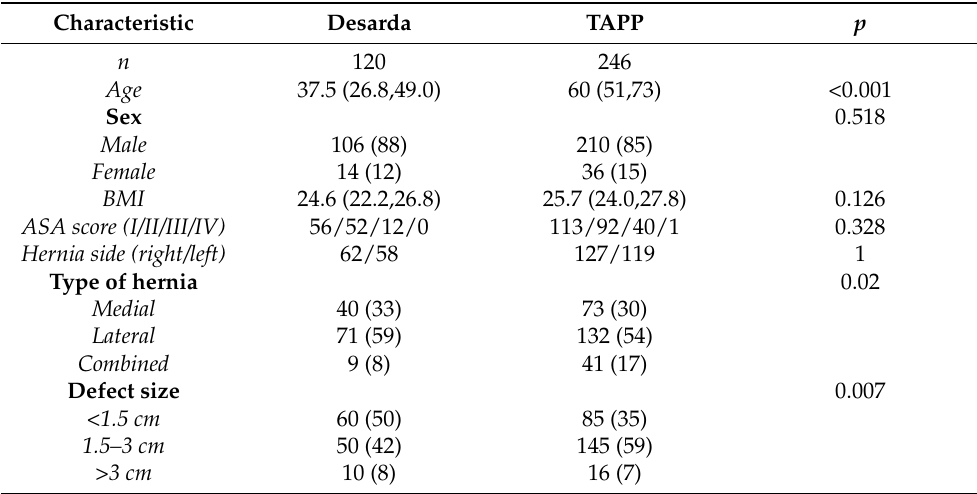
Table 1. Baseline characteristics of unmatched patient cohorts by operative method. Data are given